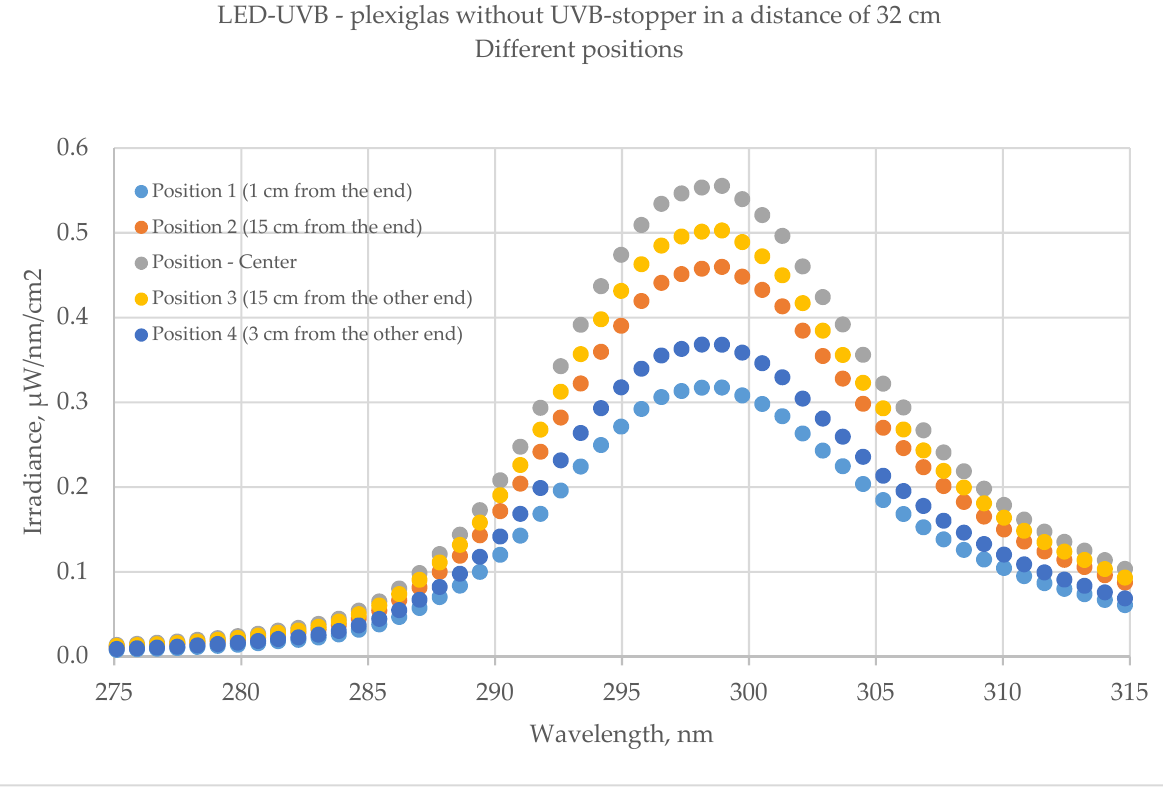
Figure A2. Irradiance (275–315 nm) of the LED-UVB 295 luminaire at a distance of 32 cm. If a distance for the UVB-exposure differed from 32 cm, the irradiance at 32 cm and at the chosen distance, e.g., 10 cm, was measured by a handheld UVB-photometer The vitamin D producing capacity of the LED-UVB 295 luminaire was calculated by using the individual factors for the conversion of 7-dehydrocholesterol to vitamin D 3 [20], i.e., at each wavelength, the irradiance was multiplied by the CIE-factor. The results are illustrated in Figure A3.